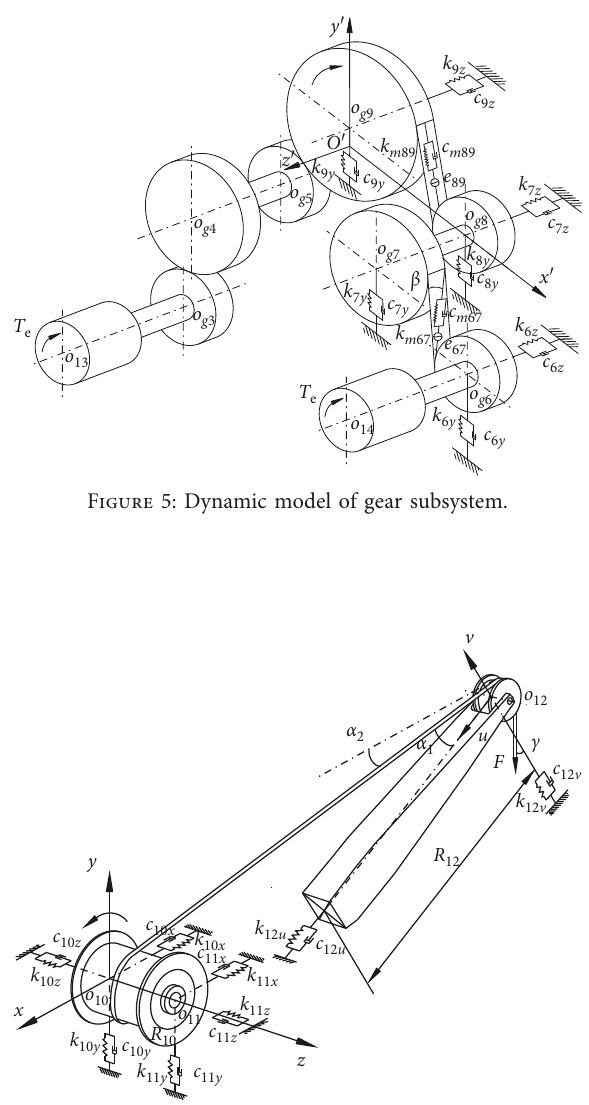
Figure 6: Dynamic model of rope subsystem. torsional stiffness of couplings, k stiffness of intermediate shafts, and k , k of bolts; k are the brace stiffness of bearing and k 5 z 8 z are equivalent stiffness of bolts; c equivalent rotary dampings of couplings, c the equivalent rotary dampings of intermediate shafts, and c is the equivalent rotary damping of bolts; c 0910